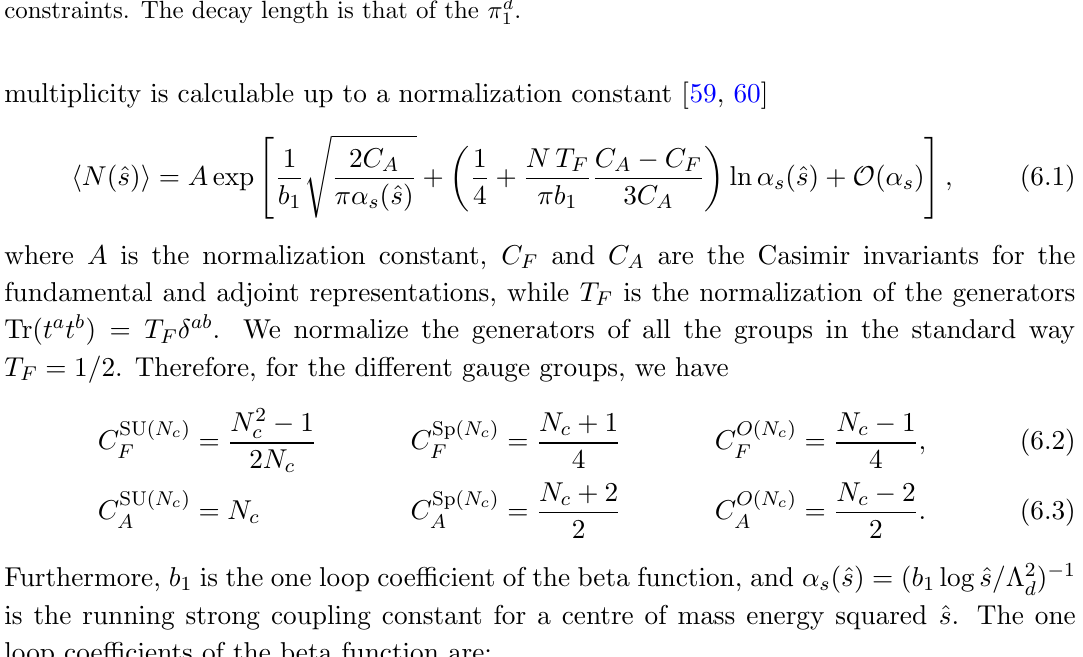
Figure 9. Allowed region of parameter space for the benchmark CIIIa for di(cid:11)erent ratios of the decay widths. The mass of the lightest pion is kept at a constant value of 75 GeV. The contour lines represent constant values of m (cid:25) a =f . The red region is excluded by perturbative unitarity 1 constraints. The decay length is that of the (cid:25) d 1